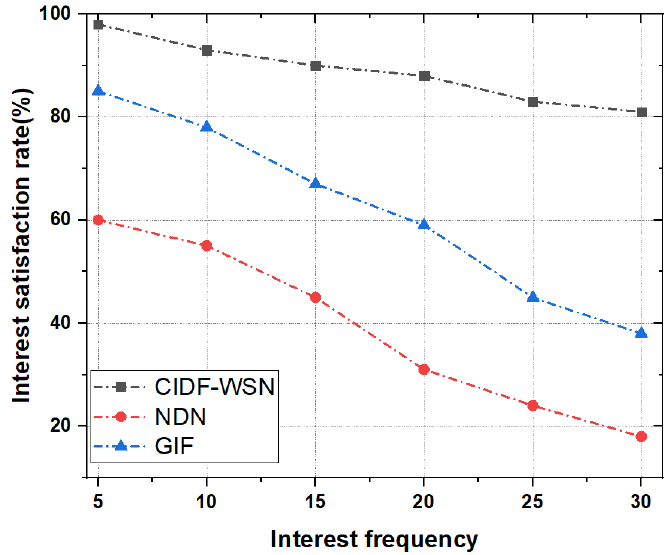
Figure 7. Interest satisfaction rate as a function of